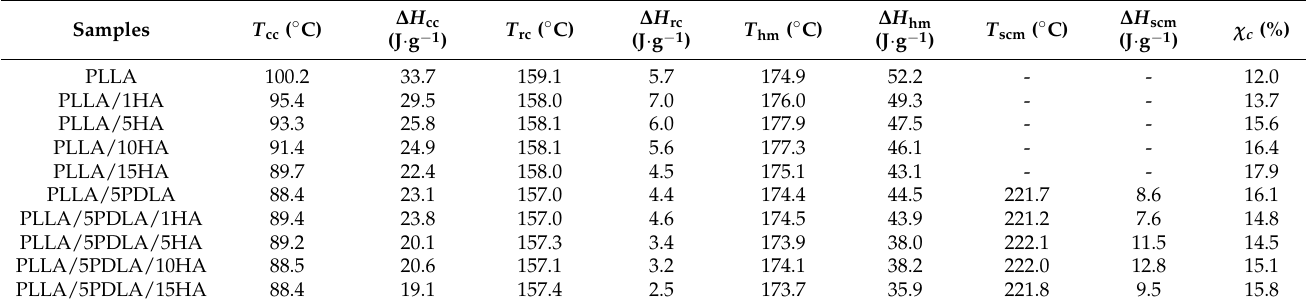
Table 2. Non-isothermal crystallization data of samples from cold mold (50 ◦ C).